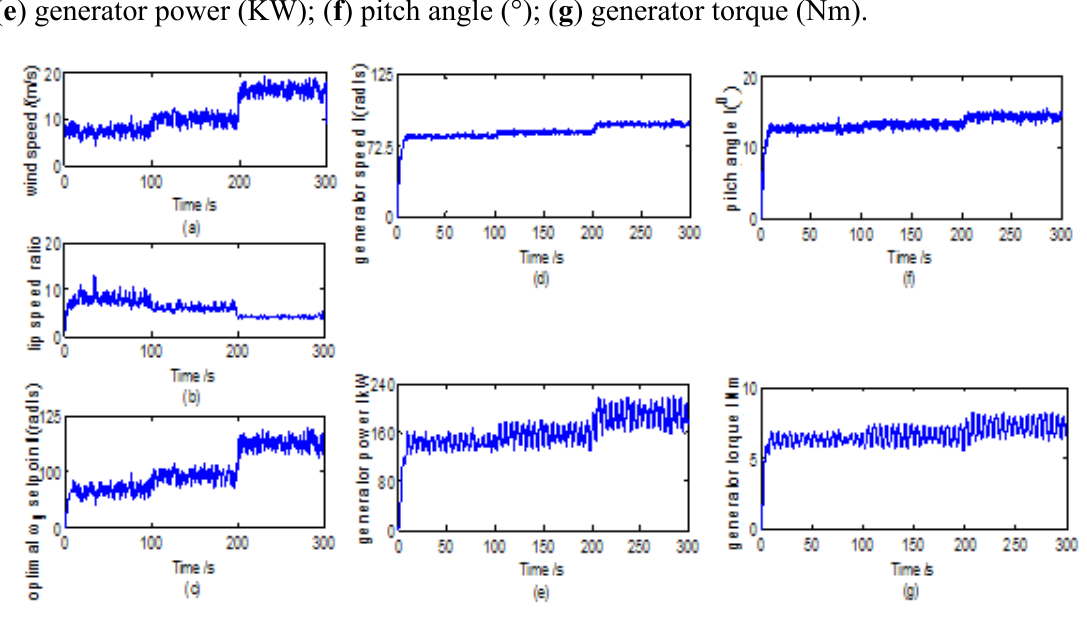
Figure 5. (cid:1834) reliable control for normal WECS based on stochastic PWA model: ( a ) wind (cid:2998) speed (m/s); ( b ) tip speed ratio; ( c ) optimal (cid:2033)